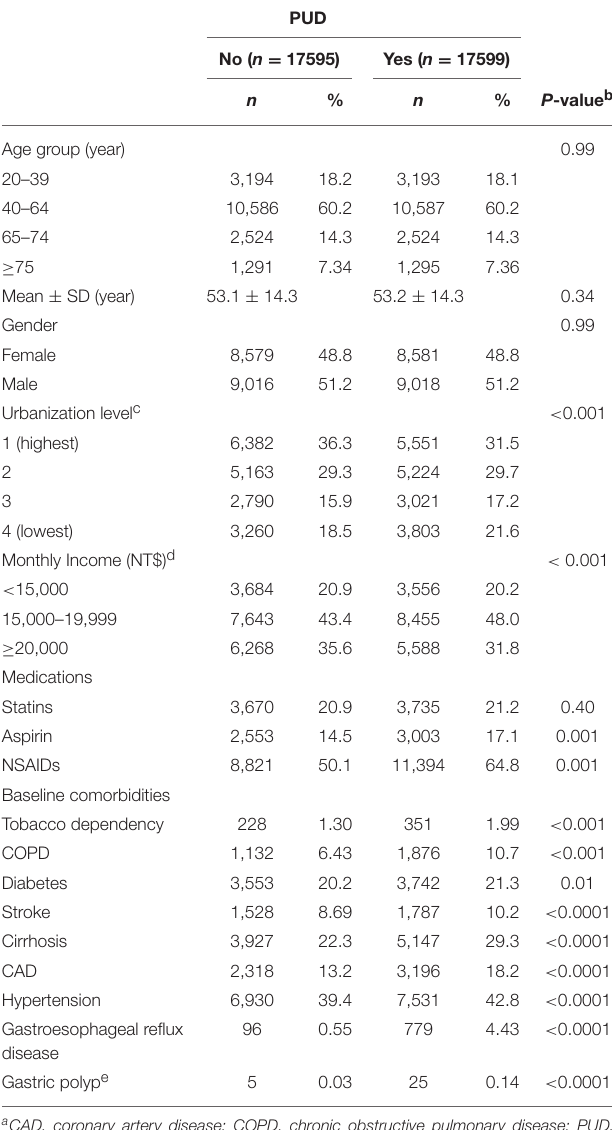
TABLE 1 | Baseline characteristics of PUD and non-PUD groups a